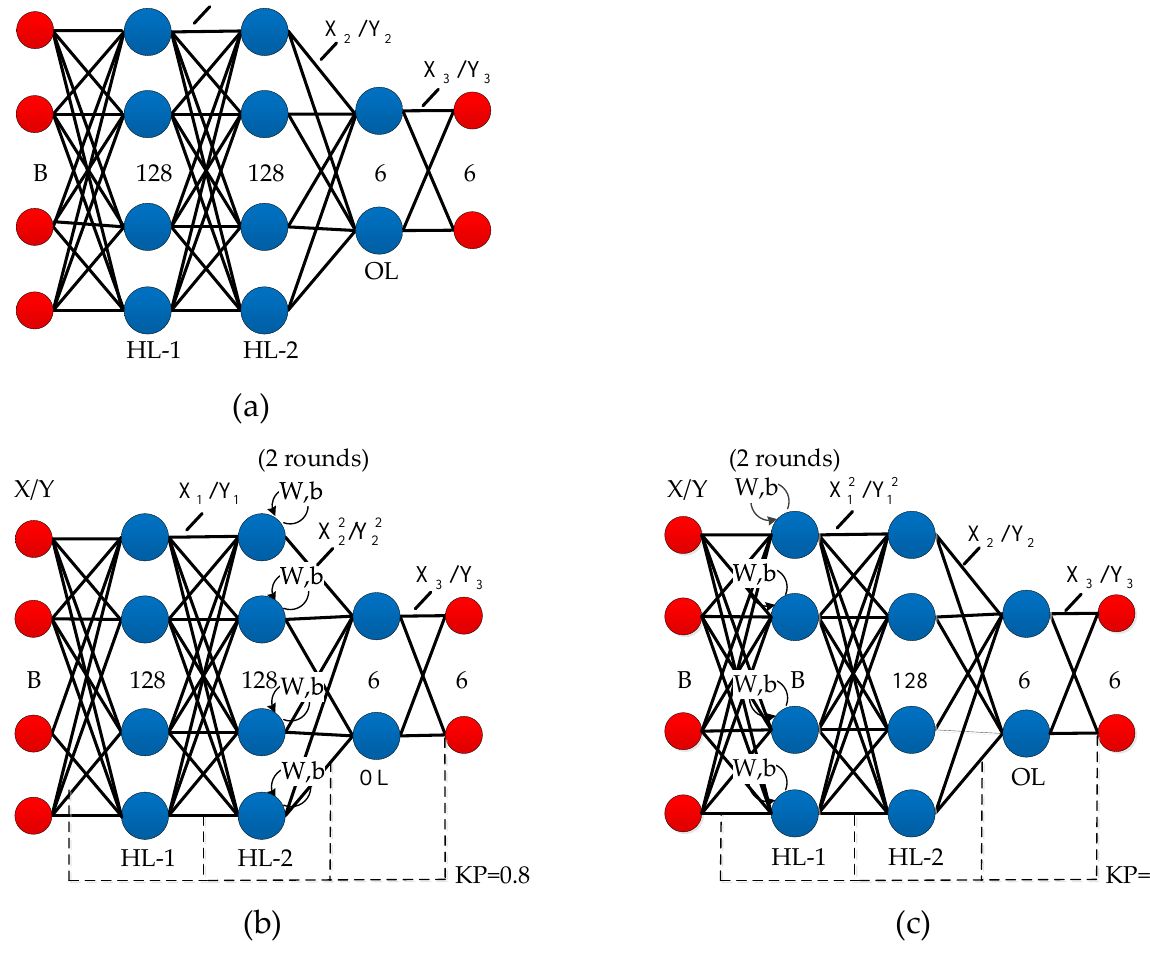
Figure 2. Architecture of the proposed SDN. ( a ) FCN; ( b ) USNet; and ( c ) CSNet.